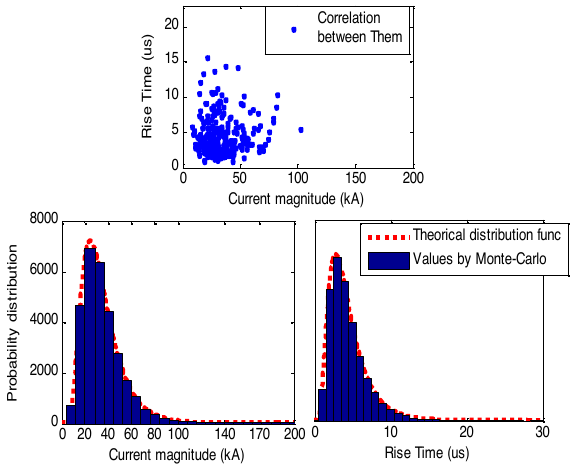
Figure 7: Distribution of generated random values of the first lightning stroke.